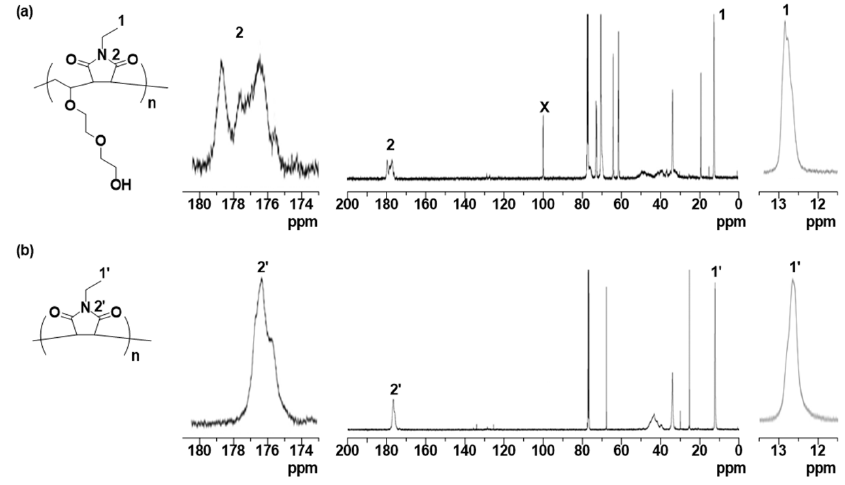
Figure 4. 13 C NMR spectrum of ( a ) poly(DEGV- alt -EtMI) and ( b ) polyEtMI in CDCl 3 . Table 1. RAFT copolymerization of DEGV and EtMI. 1